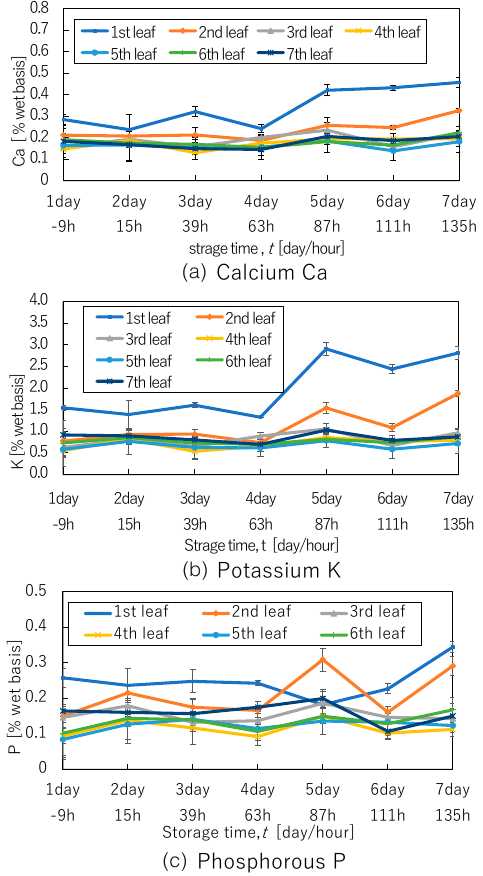
Fig. 9: Changes in the amount of element per unit volume in lettuce FFiigg.. 99 CChhaannggeess iinn tthhee aammoouunntt ooff eelleemmeenntt ppeerr uunniitt vvoolluummee iinn lleettttuuccee lleeaavveess mmeeaassuurreedd bbyy 694 leaves measured by XRF XRF aannaallyyssiiss.. 695